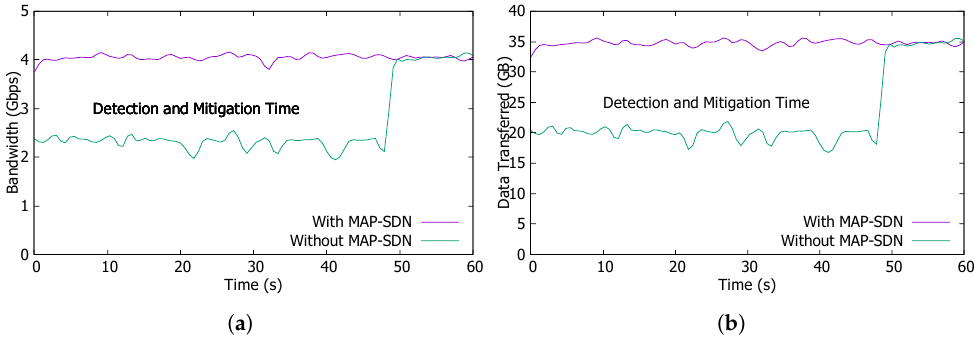
Figure 6. Real-time Performance Comparison of MAP-SDN. ( a ) Bandwidth with/without anomaly traffic. ( b ) Data transfer with/wihtout anomaly